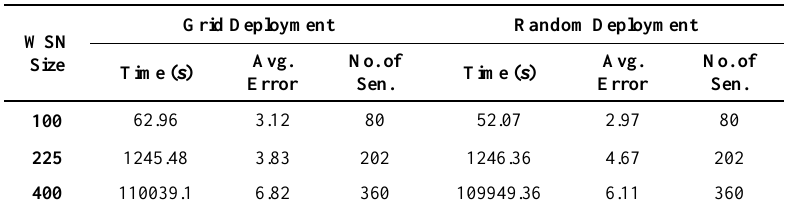
Table 1. Result of APIT algorithm